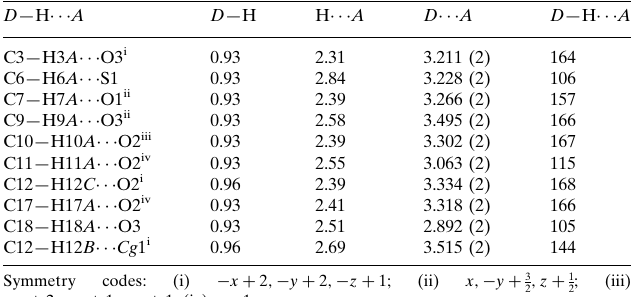
Hydrogen-bond geometry (A˚ , (cid:3) ). Cg1 is the centroid of the S1/C8–C11 thiophene